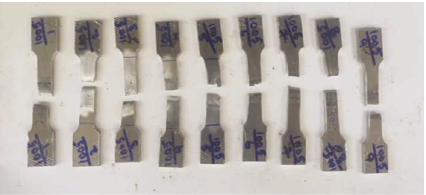
Figure 4: Fractured sample in the tensile test.